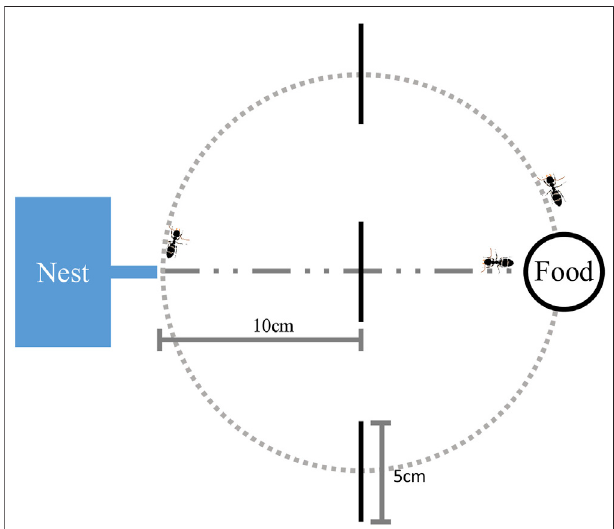
FIGURE 1 | Experimental setup. The dotted line indicates the initial pheromonepath, wherethetrailpheromonewasdepositedalongacirclewith a radius of 10 cm. The dash-dotted line indicates the shortcut path. A feeder platformwasplacedontheedgeofthecircleandthenestwasplacedon the other side. The black vertical lines represent the decision